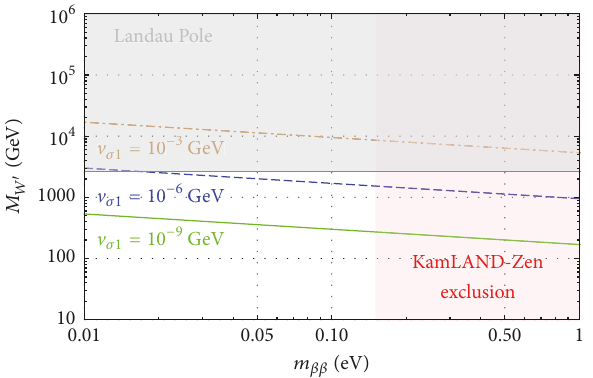
Figure 5: Lower mass bound on the 𝑊 耠 mass from the nonobser- vation of the neutrinoless double beta decay with different choices for the vev of scalar field 𝜎 1 which controls the parameter 𝑀 2 푊푊 󸀠 in (24). The gray solid area denotes Landau pole upper limit [12, 50] and light red denotes the KamLAND-Zen exclusion